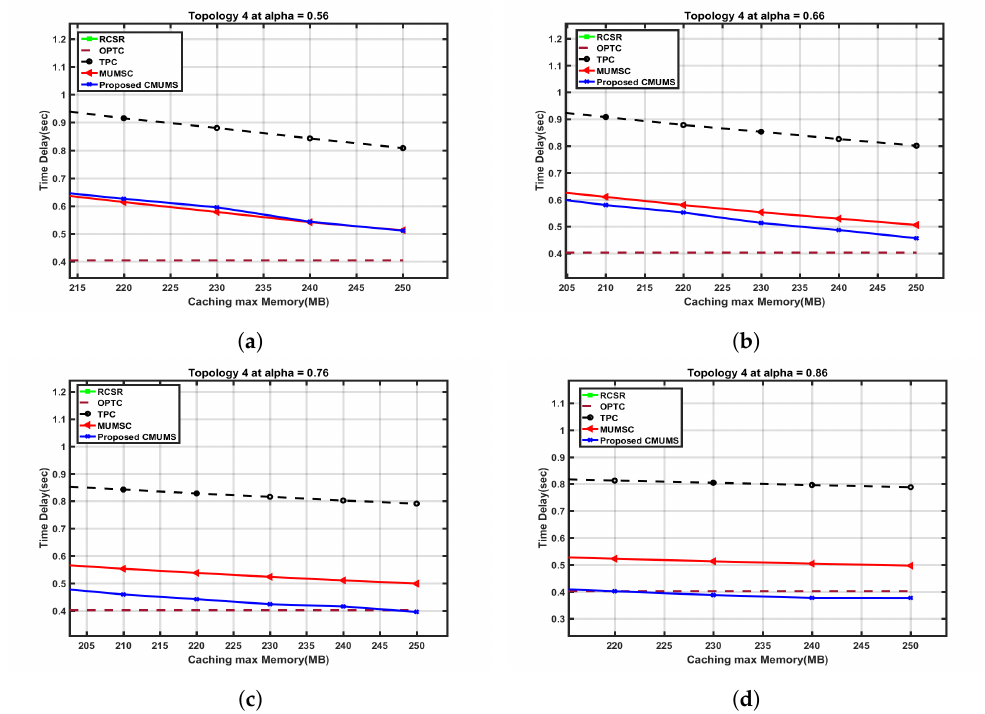
Figure 8. Cross-section of Time Delay vs. Q up to 250 MB in topology 4 at different α . ( a ) Time delay vs. Q up to 250 MB; ( b ) Time delay vs. Q up to 250 MB; ( c ) Time delay vs. Q up to 250 MB; ( d ) Time delay vs. Q up to 250 MB. Table 3. Time Delay vs. Average task size at different α for comparing the referenced algorithms in [21] with CMUMS at Q = 250